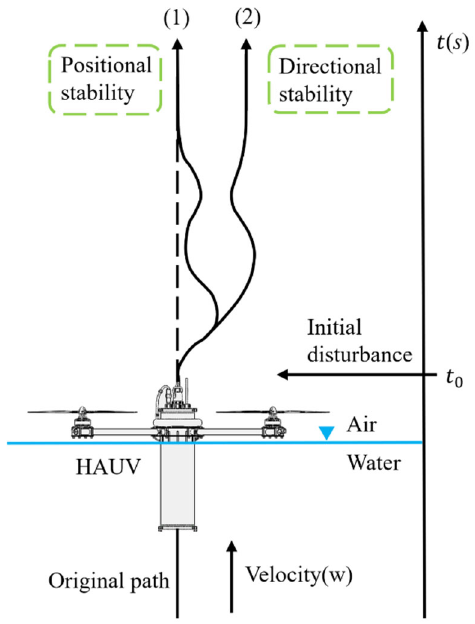
Figure 4. The definition of kinematic